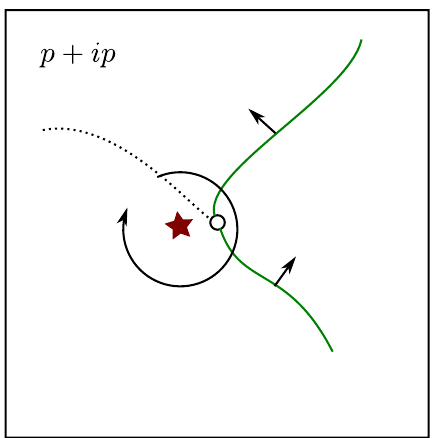
Figure 3 . Here we have a spatial picture of a 2+1D fermionic system with a unitary symmetry C 2 = ( − 1) F . At the white circle, two co-oriented C defects (green) fuse to a fermion parity defect (dashed). This junction may trap a Majorana fermion. However, if it does, then by layering a p + ip superconductor (so taking β 3 = 1 ∈ Ω 3 ), since the fermion parity defect ends at the fusion Spin junction, the p + ip superconductor sees a vortex there (red star), which also traps a Majorana fermion [82]. This Majorana may be paired with the other one to create a featureless fusion junction. Thus, this decoration does not actually contribute an anomaly in this symmetry